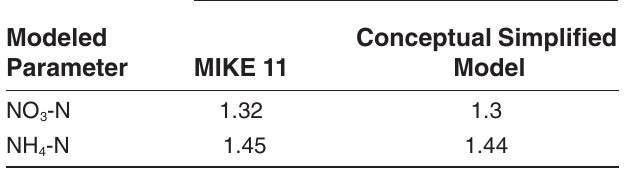
Comparison of the Standard Deviation for both the MIKE 11and the Conceptual Simplified Model The Standard